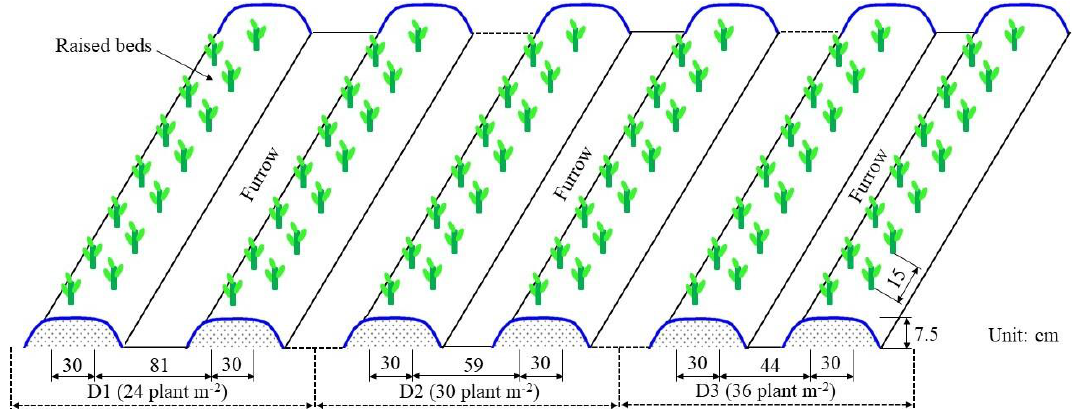
Figure 3. Schematic diagram of the arrangement of planting rows and raised beds under the three seeding rates.